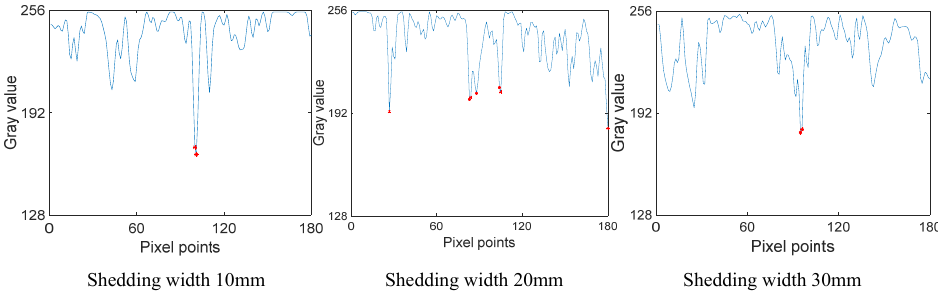
Figure 19. Picture of defect location recognition.